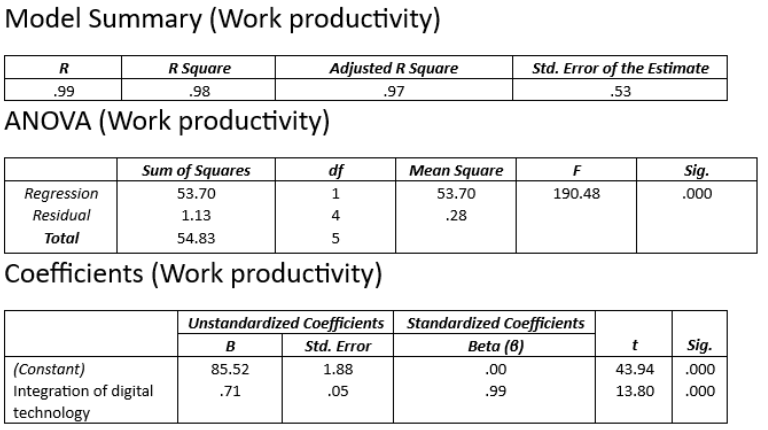
Figure 10. Linear regression: digitization and labor productivity—an average of European Union countries.